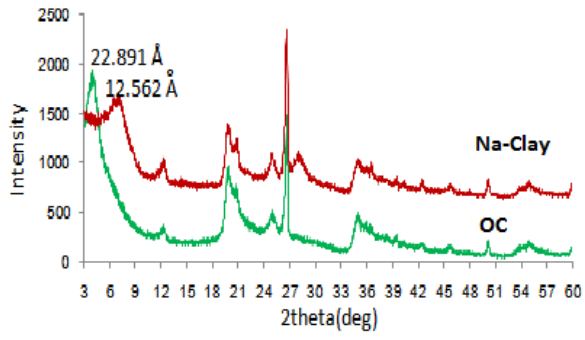
Figure 2: X ray diffraction (XRD) patterns of Na-clay and Organoclay(OC).